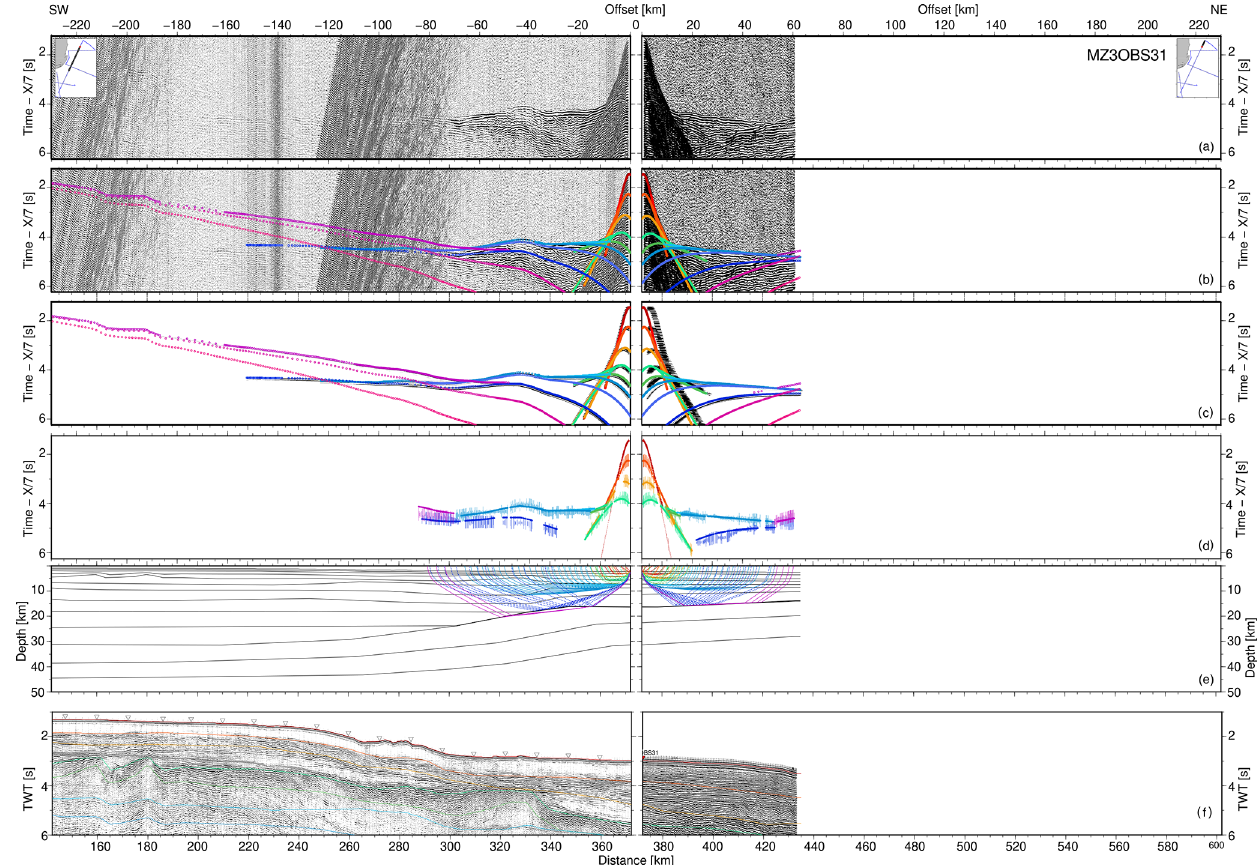
Figure 8. The same as Fig. 6 but for MZ3OBS31.